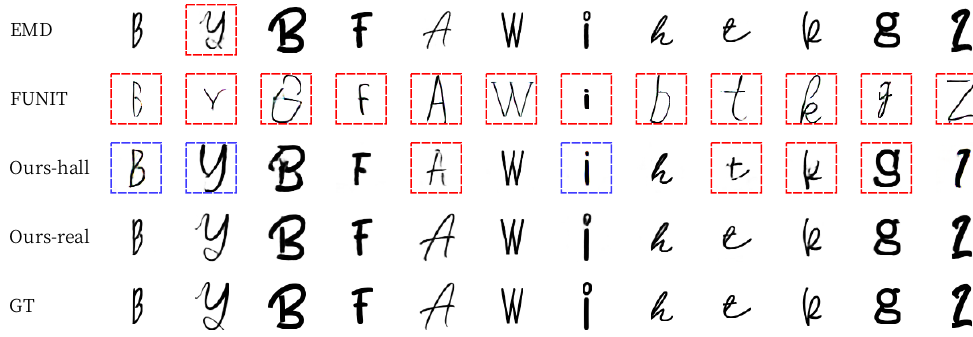
Figure 15. Examples of English seen font style generation. We show the ‘bad’ results with red box, ‘not bad’ result with blue box, and ‘good’ result without